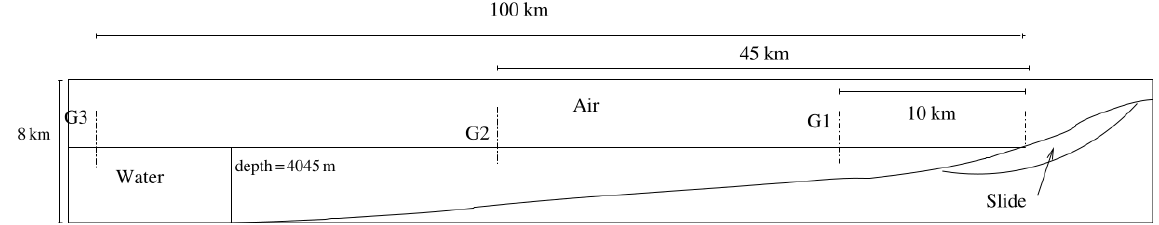
Figure 1. Cross section of the 80km 3 La Palma slide scenario considered in Abadie et al. (2012).